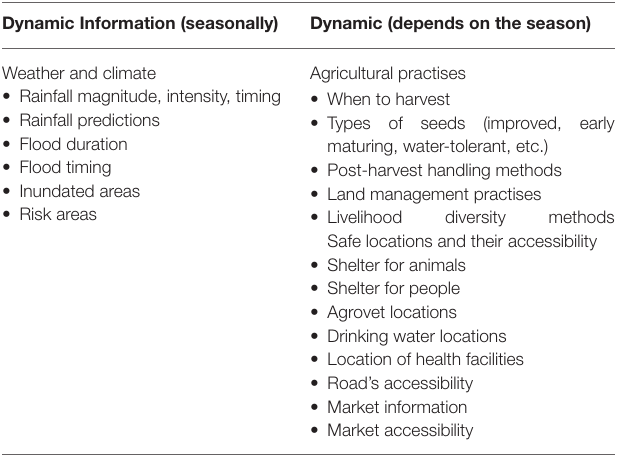
TABLE 3 | Categorisation of farmers’ information needs based on when they are required. Dynamic Information